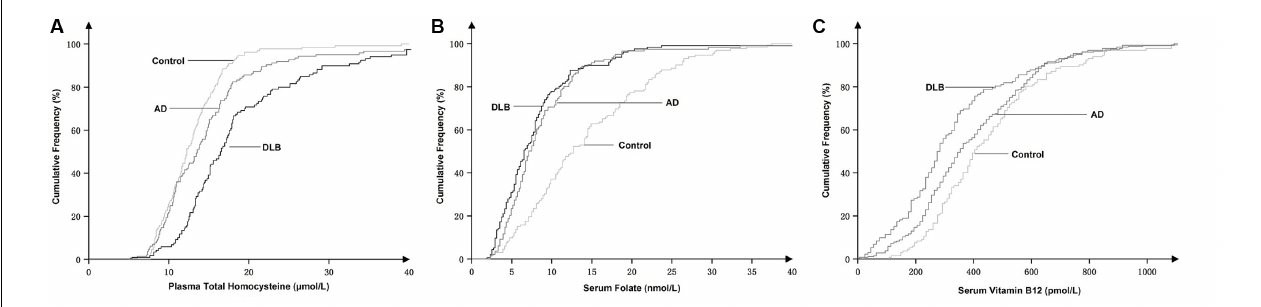
FIGURE 2 | Cumulative frequency distributions of plasma total homocysteine (tHcy) (A) , serum folate (B) , and serum vitamin B12 concentrations (C) in DLB and AD patients and healthy controls.